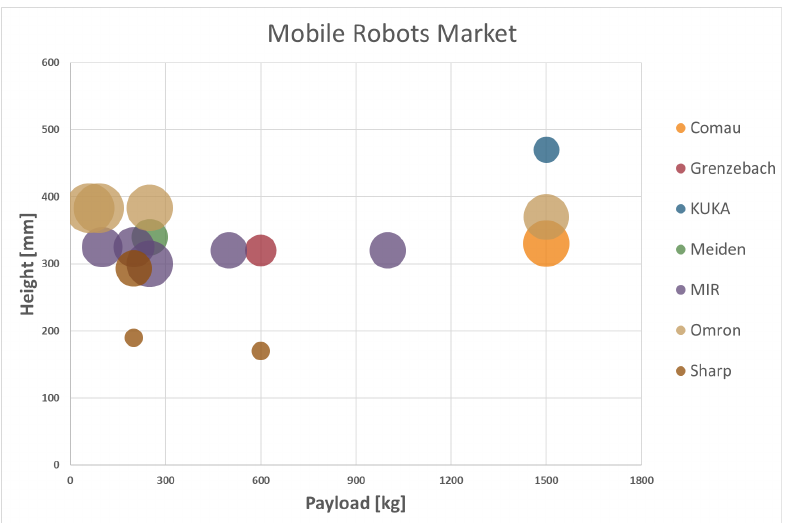
Figure 4. Mobile Robots Market: classification according to the payload, the height, and the battery charge (in hours) represented by the diameter